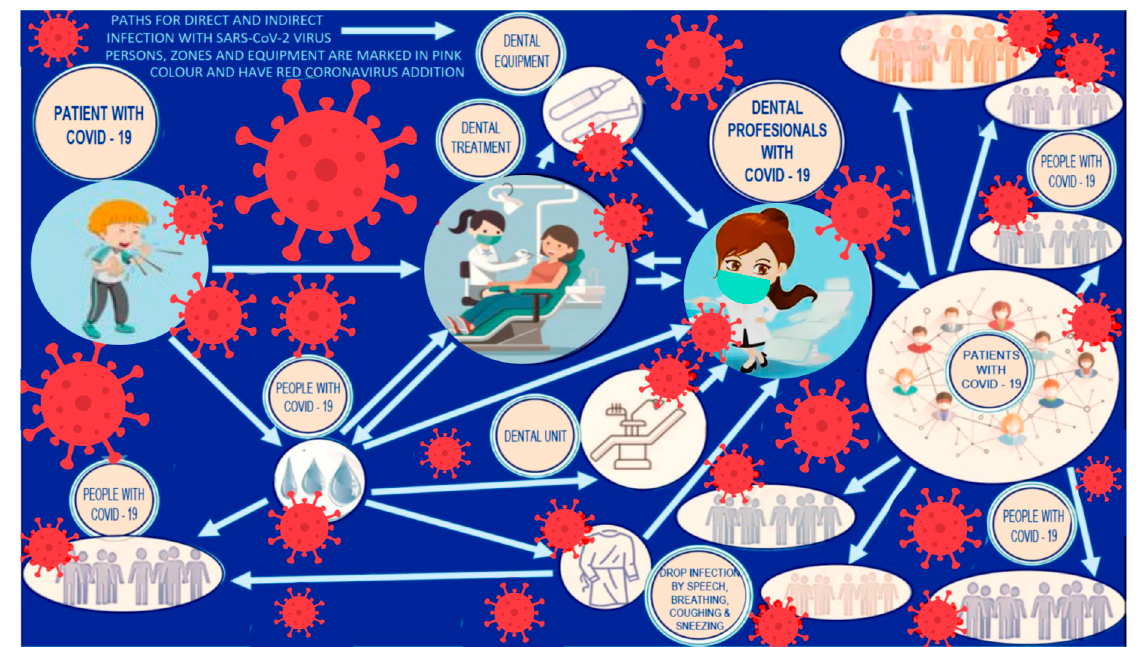
Figure 8. Spread of the COVID-19 disease in various countries of the world as of 22 February 2021.